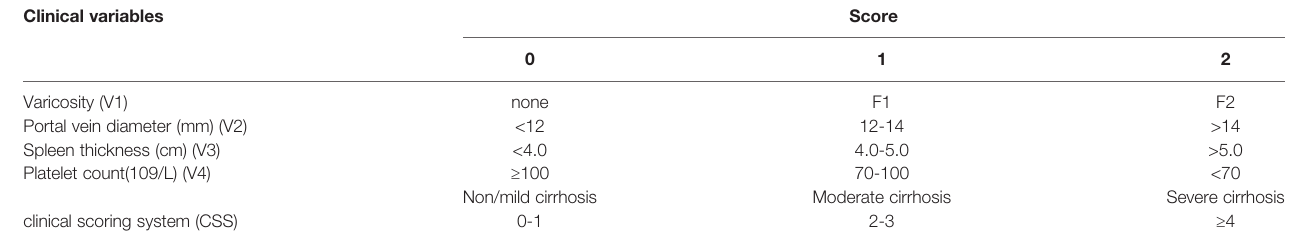
TABLE 1 | TongJi-clinical scoring model for staging liver cirrhosis. Clinical